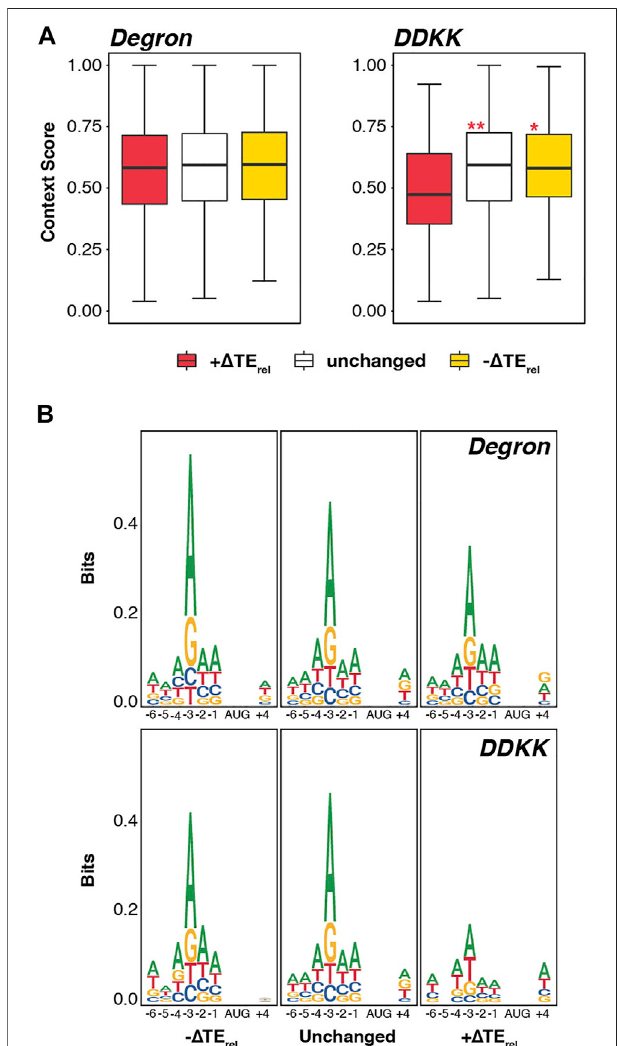
FIGURE 3 | Disruption of the eIF3 mRNA-entry-channel arm interferes with discrimination against start codons appearing in poor Kozak sequence context. (A) Box and whisker plots comparing the Kozak sequence context (nt -6 thru +4) of transcripts whose TE rel signi fi cantly increases (red), decreases (yellow), or is not signi fi cantly changed (white) in each eIF3 mutant strain. *** (cid:1) P adj < 10 − 10 , ** (cid:1) P adj < 10 − 5 , * (cid:1) P adj < 0.05, color indicates comparison set; ANOVA with post-hoc Tukey test. (B) Sequence logos of nt -6 to +4 of transcripts whose TE rel signi fi cantly increases, decreases, or is not signi fi cantly changed in each eIF3 mutant